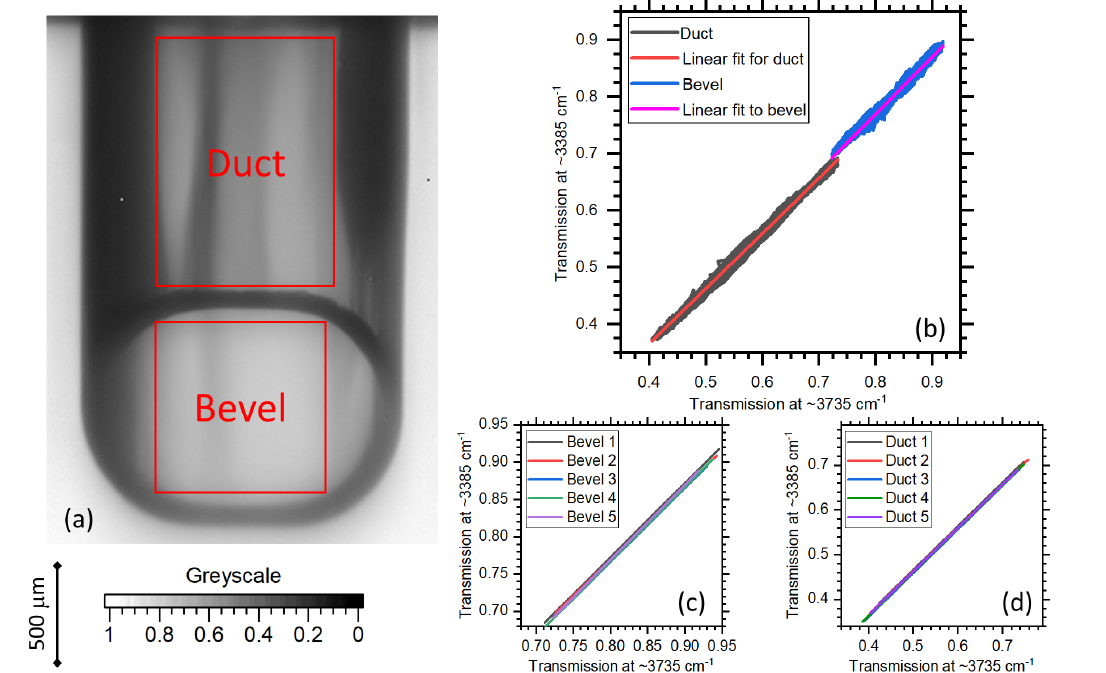
Figure 4. ( a ) Image of transmission at ≈ 3735 cm − 1 of an uncoated nozzle. ( b ) Measured transmission at ≈ 3385 cm − 1 as a function of ≈ 3735 cm − 1 for duct and bevel components of uncoated nozzle. The regions where data is extracted is highlighted in ( a ). Linear fits to data from both components is also shown in ( b ). Linear fits to five sample uncoated nozzles is shown for the bevel in ( c ) and duct in ( d